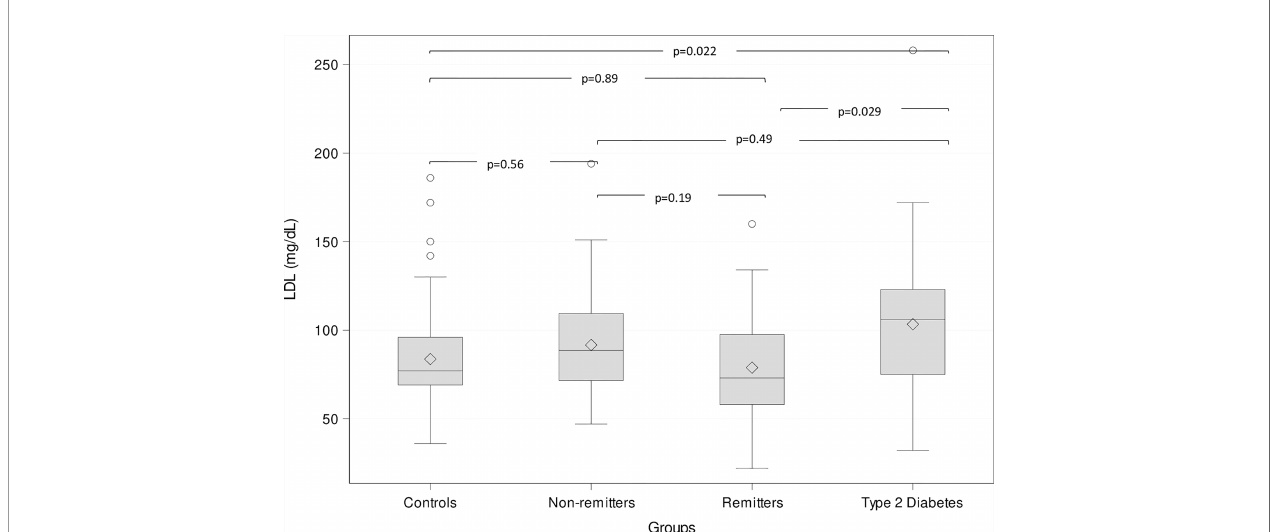
FIGURE 4 | Box plots of the comparison of serum low-density lipoprotein (LDL)-cholesterol (LDL-C) among the groups. The lines through the middle of the boxes represent the median or middle quartile, while the lines at the top and bottom of box represent the upper and lower quartiles, respectively. The upper and lower whiskers represent the scores outside the middle 50%, while the circles represent the outliers. Serum LDL-C was signi fi cantly higher in the subjects with type 2 diabetes compared to the controls and the remitters, but similar to the non-remitters